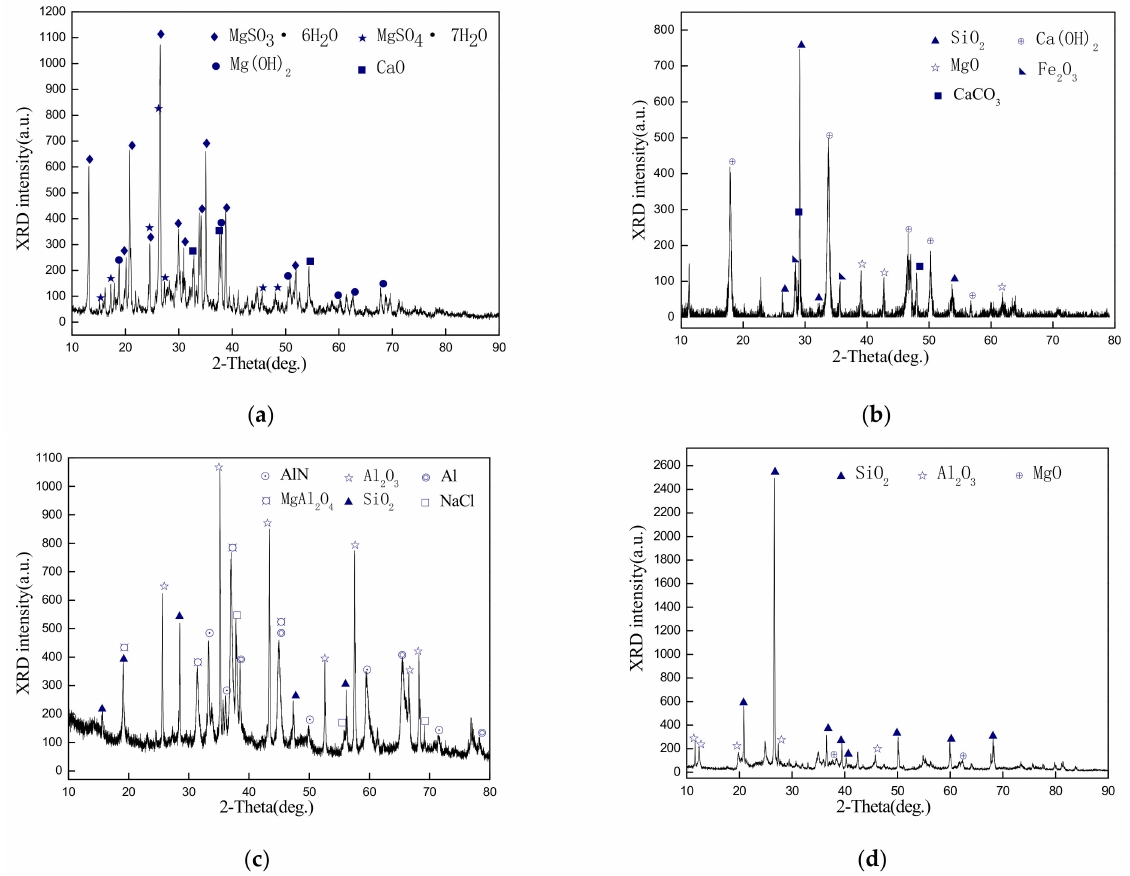
Figure 1. XRD patterns of raw materials: ( a ) magnesium desulfurization slag; ( b ) carbide slag; ( c ) aluminum slag; ( d ) coal